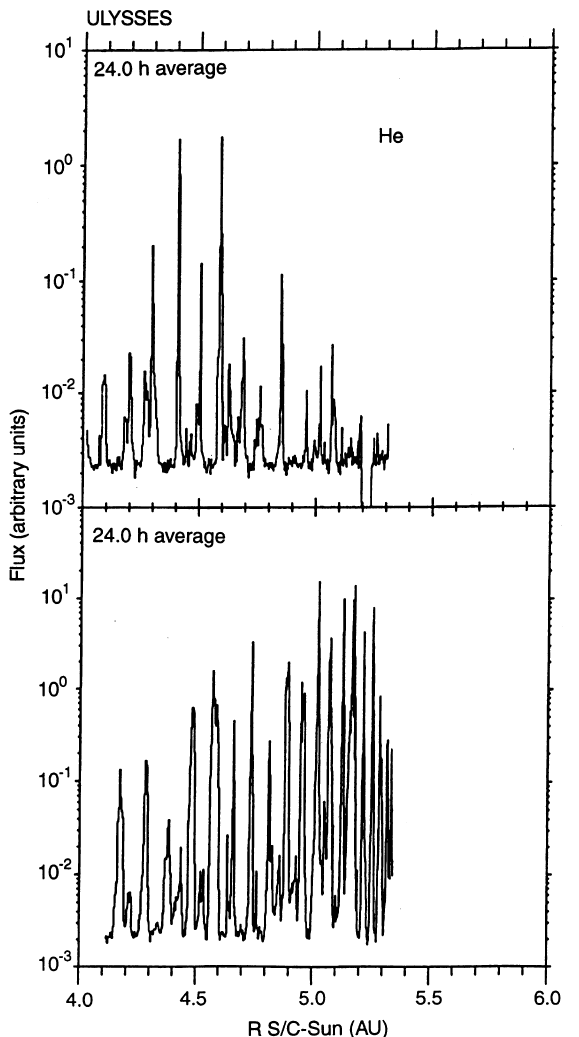
Fig. 2. Same data as shown in Fig. 1, however, plotted against radial distance from the Sun ( upper panel , inbound pass; lower panel ,